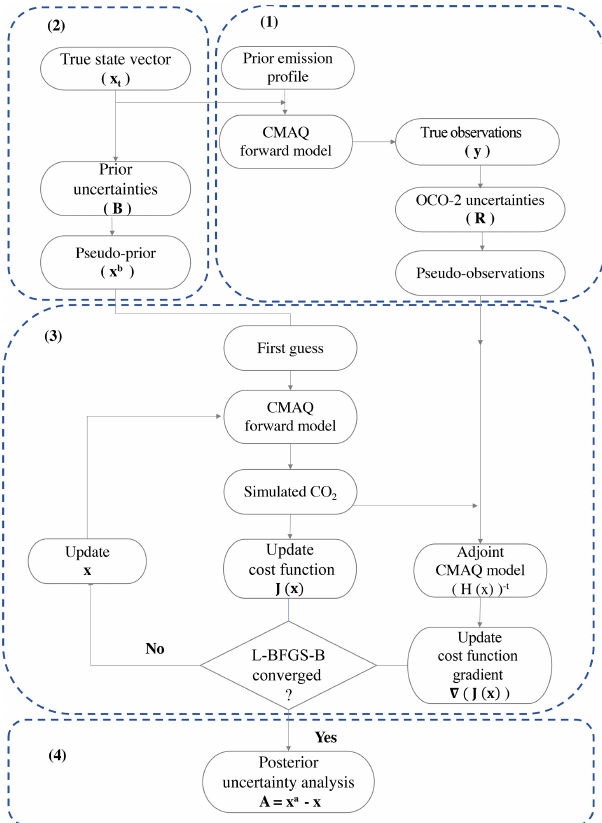
Figure 1. Diagram representing an overview of the observing sys- tem simulation experiments (OSSEs) and how the inversion is per- formed using the L-BFGS-B minimization